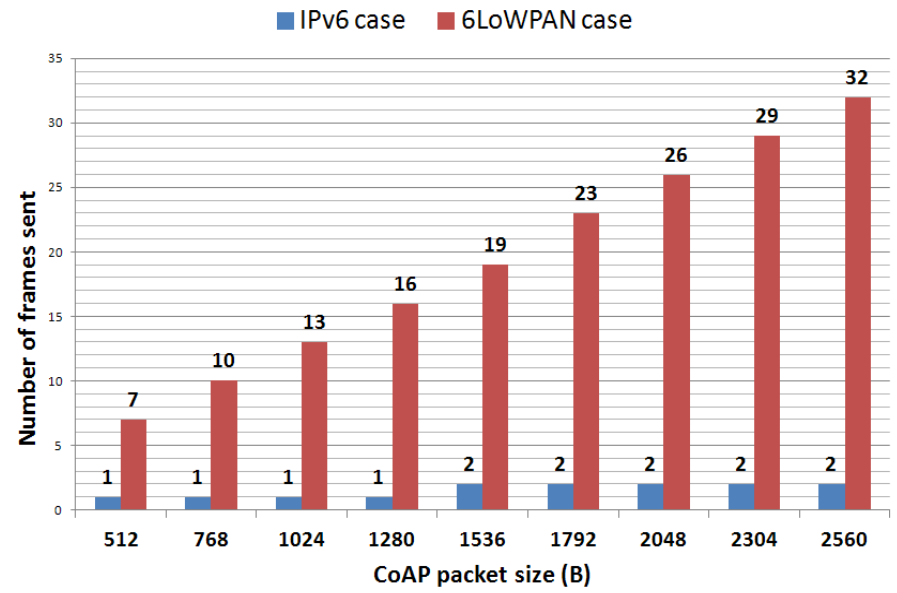
Figure 5. Number of packets sent as a function of the CoAP packet size.